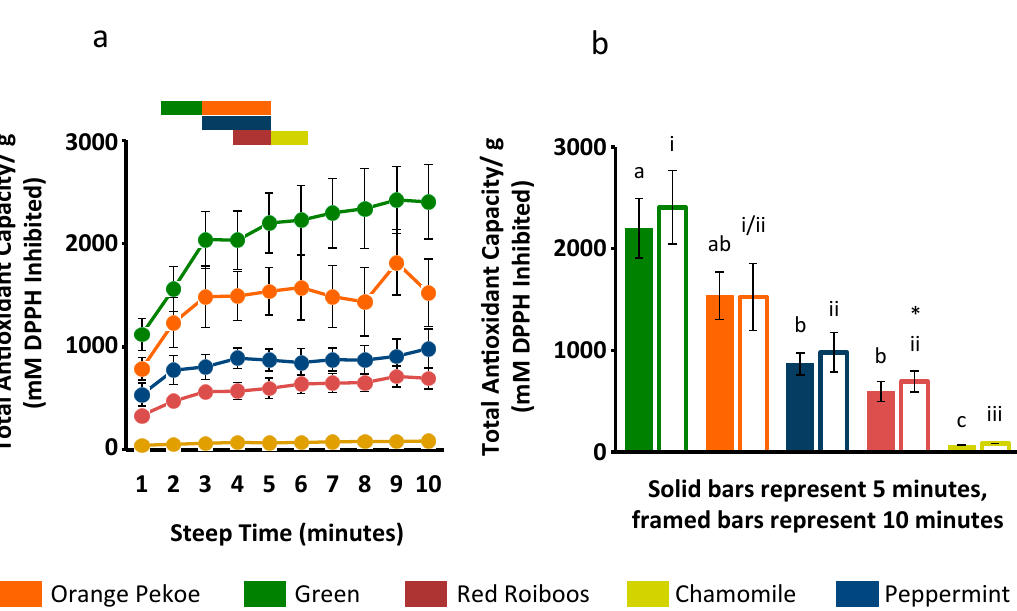
Figure 4. Predicted total antioxidant capacity (per gram) of five different teabag types after multiple points of steep time. ( a ) predicted total antioxidant capacity per gram of tea for a steep time duration of 1–10 min. Coloured bars indicate the manufacturers suggested steep time for each tea type; ( b ) predicted total antioxidant capacity/g of tea after a steep time of 5 min (solid coloured bars) compared to after 10 min (framed bars). * Represents a significant difference in total antioxidant capacity between 5 and 10 min for Chamomile ( p < 0.05). Between tea comparisons were made separately for 5 min (letters) and 10 min (Roman numerals) data ( p < 0.05). Specifically, total antioxidant capacity at 5 min significantly differs among tea types that have different letters while total antioxidant capacity at 10 min significantly differs among tea types that have different Roman numerals.